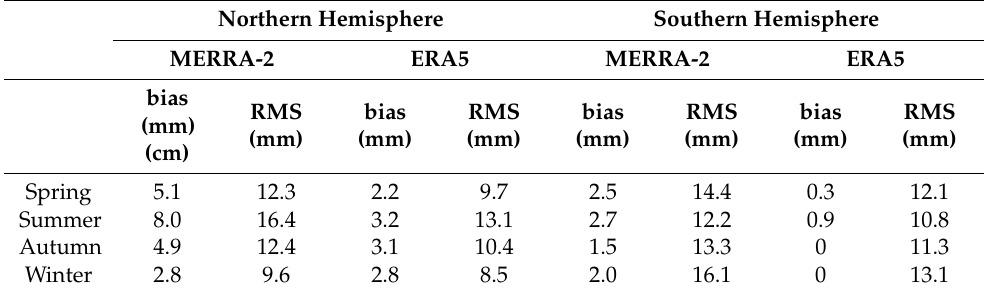
Table 2. Average ZTD bias and RMS for MERRA-2 and ERA5 pressure-level data in different seasons.